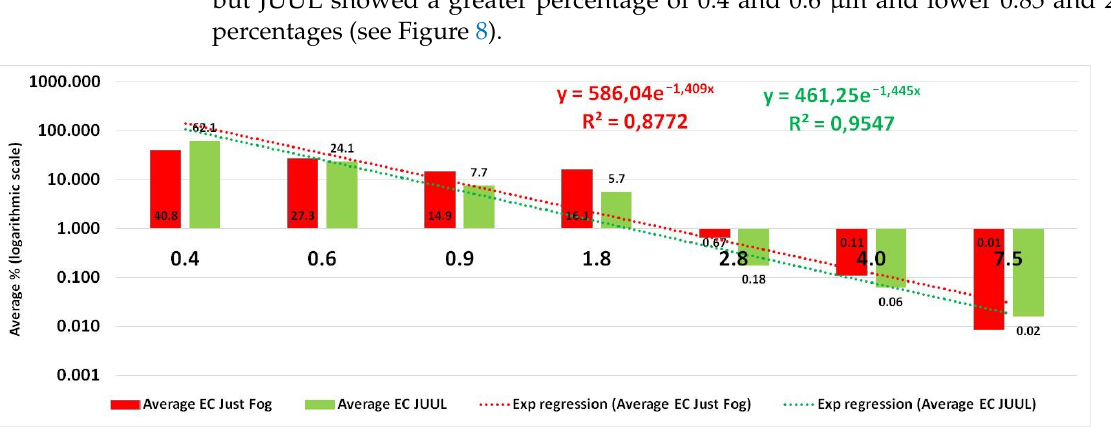
ent, but JUUL showed a greater percentage of 0.4 and 0.6 µm and lower 0.85 and 2.75 µm